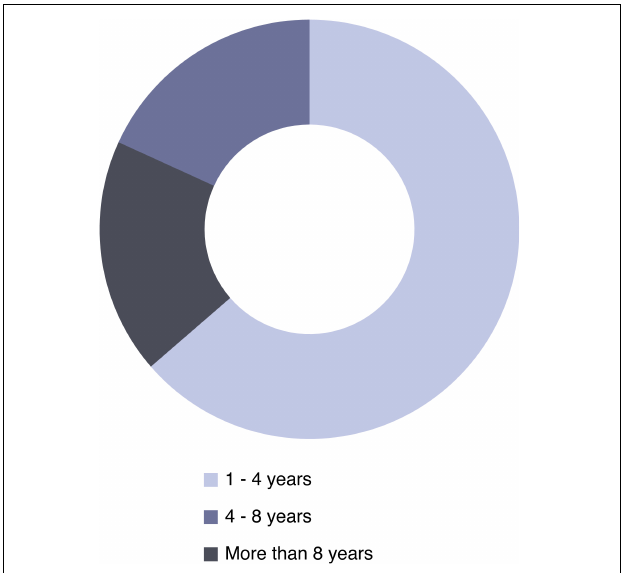
FIGURE 5 | Duration time of the CWC active restoration actions carried out to date ( N =